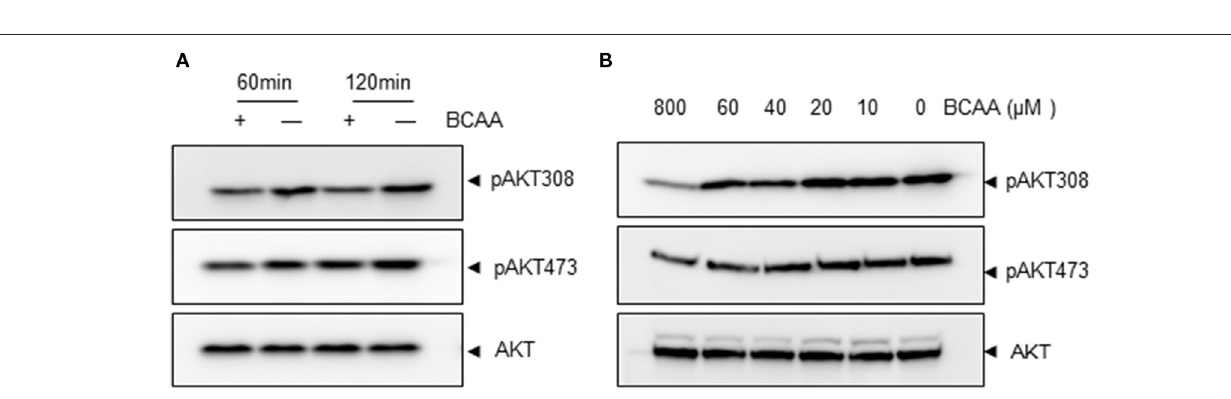
FIGURE 3 | BCAA starvation induces AKT phosphorylation. Measurements of Ser473 or Thr308 phosphorylation of AKT (pAKT) or total AKT (60KD band) using immunoblots. (A) MEF cells were treated with BCAA deprivation ( − ) for indicated time. (B) MEF cells were treated with different concentrations of BCAAs for 2h. Data showed 1 experiment representative of